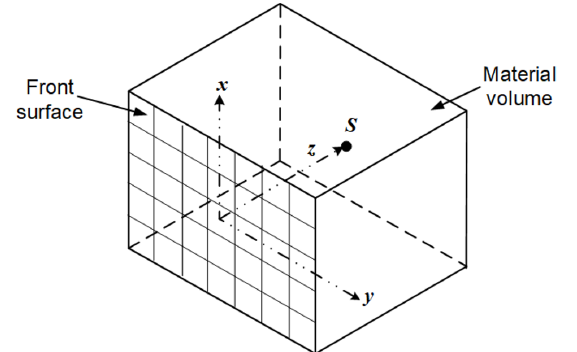
Figure 1. Radioactive point source S buried in a material